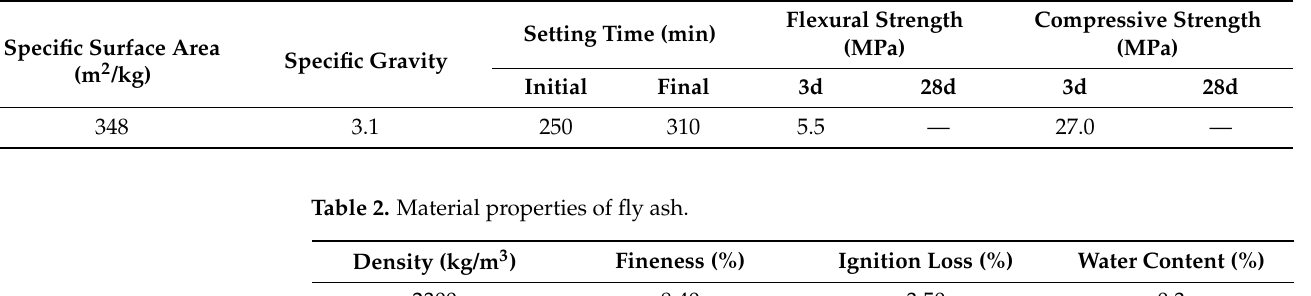
Table 1. Material properties of cement.